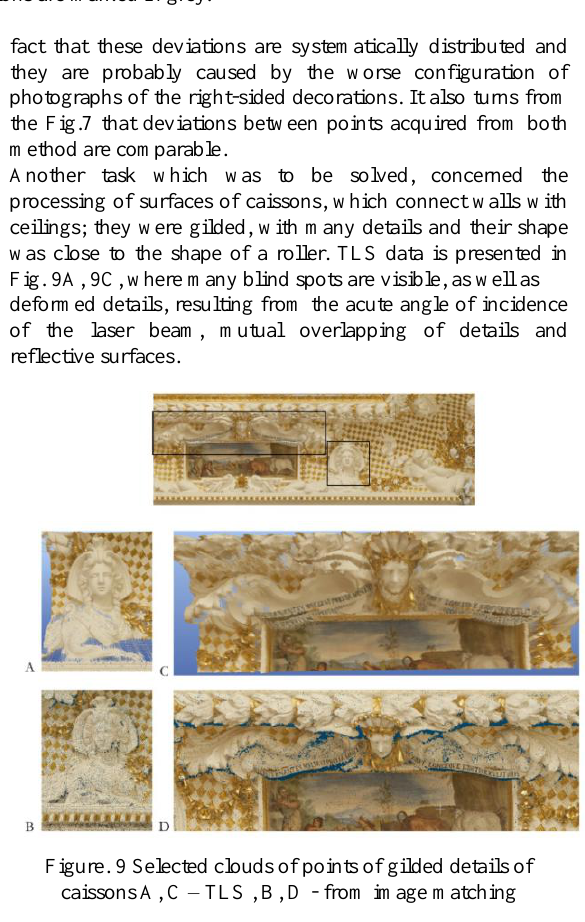
Figure. 7. A Deviations of points from reference planes. A - the point cloud from image matching, B - the point cloud from terrestrial laser scanning. The null deviations are marked in grey.